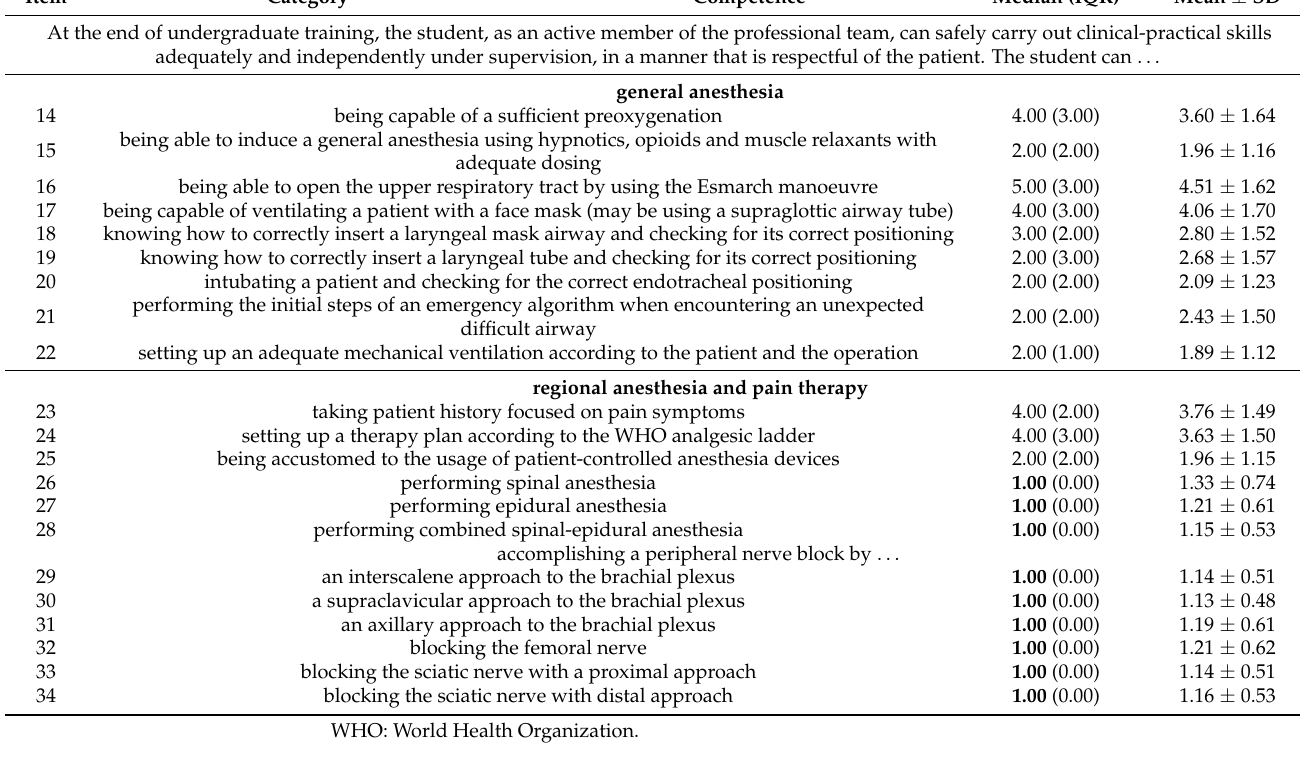
Table 3. Overview of all items asked in the individual categories in the field of intensive care medicine and the average rating of the participants from 1 (“not relevant at all”) to 6 (“very relevant”) as median and IQR and mean value and